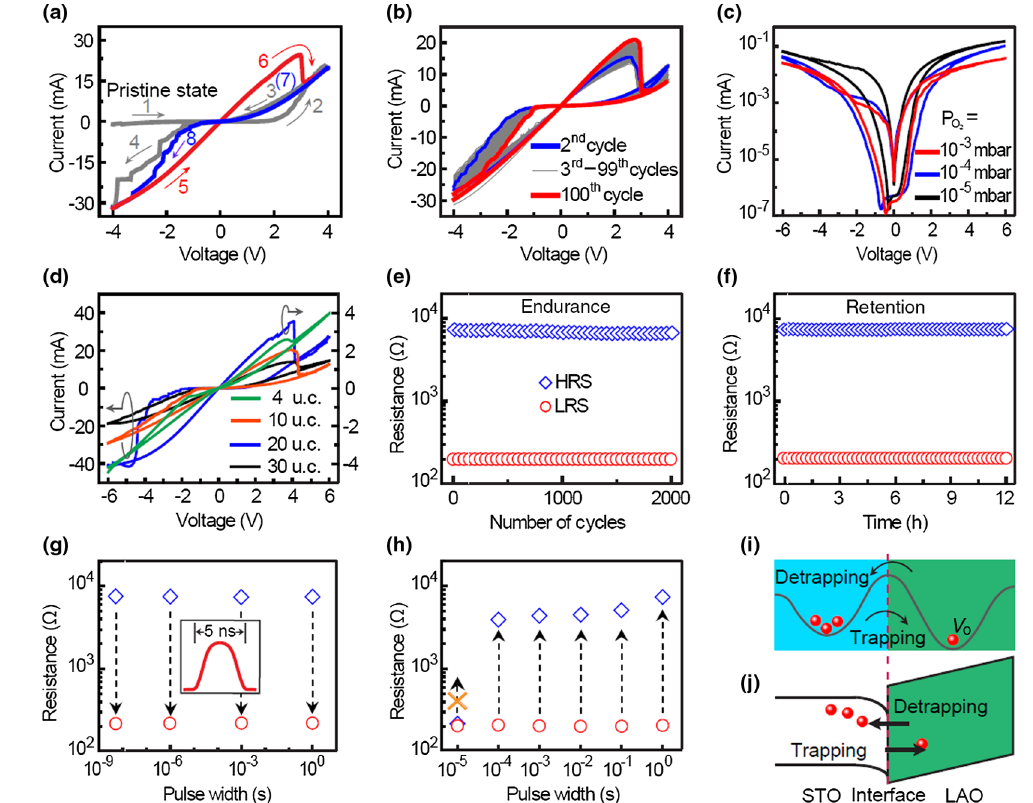
FIG. 3. (a) Forming process (voltage sweeps 1–4) transforms the device into the switchable states (sweeps 5–8). The red and the blue lines represent the LRS and HRS, respectively. The arrows mark the directions of the sweeping voltage. (b) After the forming process, the bipolar resistance switching is very stable during the successive voltage sweeps. (c) Reliable bipolar resistance switching, illustrated as absolute values of current as a function of voltages, can be observed in the devices with 10-u.c. LAO grown at different oxygen pressures. The y axes of (a)–(c) share the same label and unit. (d) Bipolar resistance switching in the memristors made of LAO films with different thickness (4 to 30 u.c.). (e),(f) The endurance and the retention data, respectively, with a readout voltage of 0.2 V. (g) Write speed can be as fast as 5 ns. (The pulse shape as recorded by an oscilloscope is shown in the inset.) Before the writing operations, voltage pulses of þ 4 V with a pulse width of 1 s are used to set the device to the HRS, and (cid:2) 4 V pulses with different pulse widths areapplied toobtaintheLRS.(h)Erasetakes morethan 100 (cid:1) s .Voltage pulsesof þ 4 V are usedtoaccomplishthe transitionfrom the LRS to HRS. (i) Schematic illustrating the electric-field-induced trapping and detrapping of positively charged oxygen vacancies across an asymmetric energy barrier at the LAO/STO interface. (j) Schematic band diagram of the LAO/STO